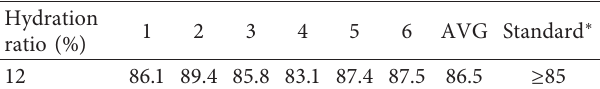
Table 2: 28-day compressive strength measured value of grouting material (unit: